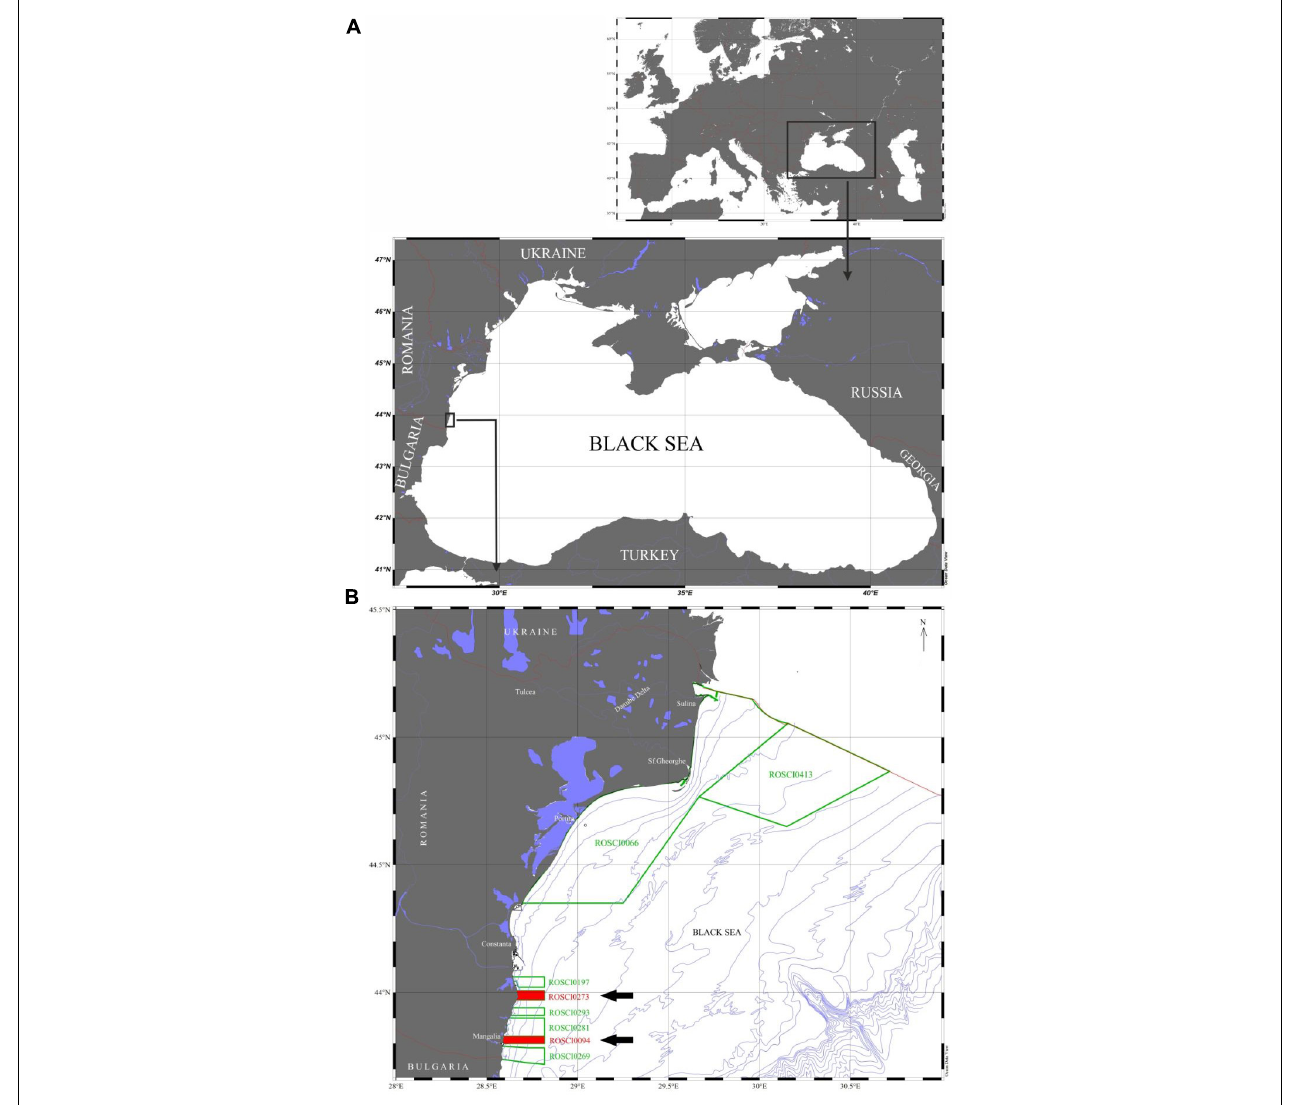
FIGURE 1 | Maps outlining (A) the approximate location of the study area in the southern Romanian Black Sea, and (B) the location of eight Natura 2000 Marine Protected Areas (MPAs) highlighting (red polygons pointed by arrows) the Cape Tuzla MPA (ROSCI0273) and the Mangalia submarine Sulfur springs MPA